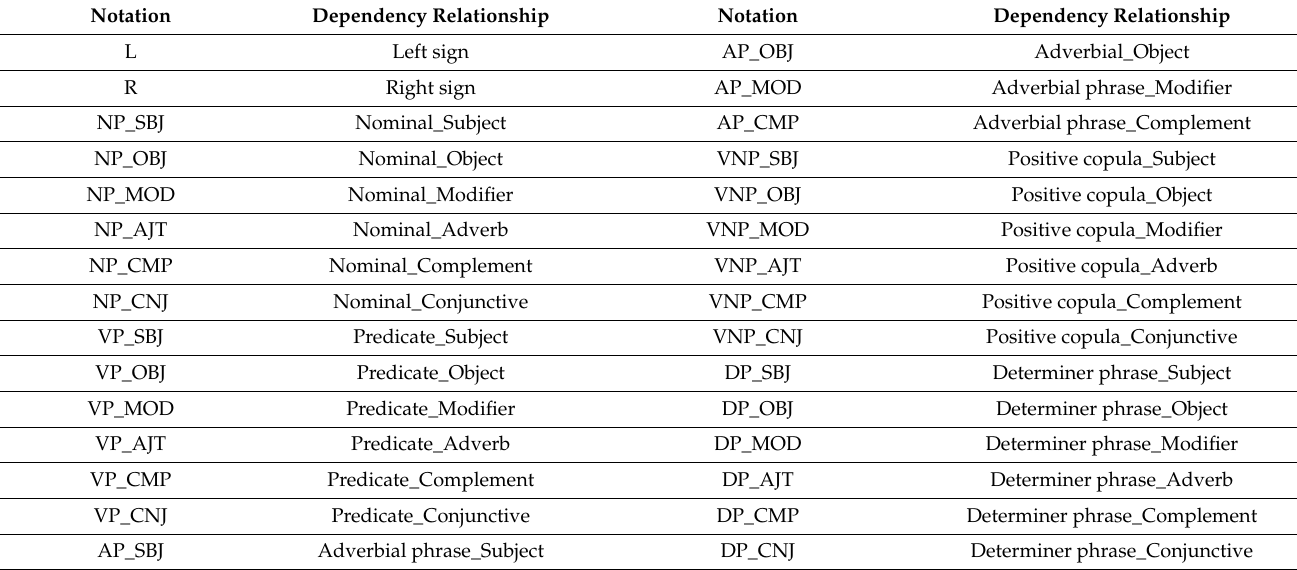
Table 1. Korean dependency relation tag set.